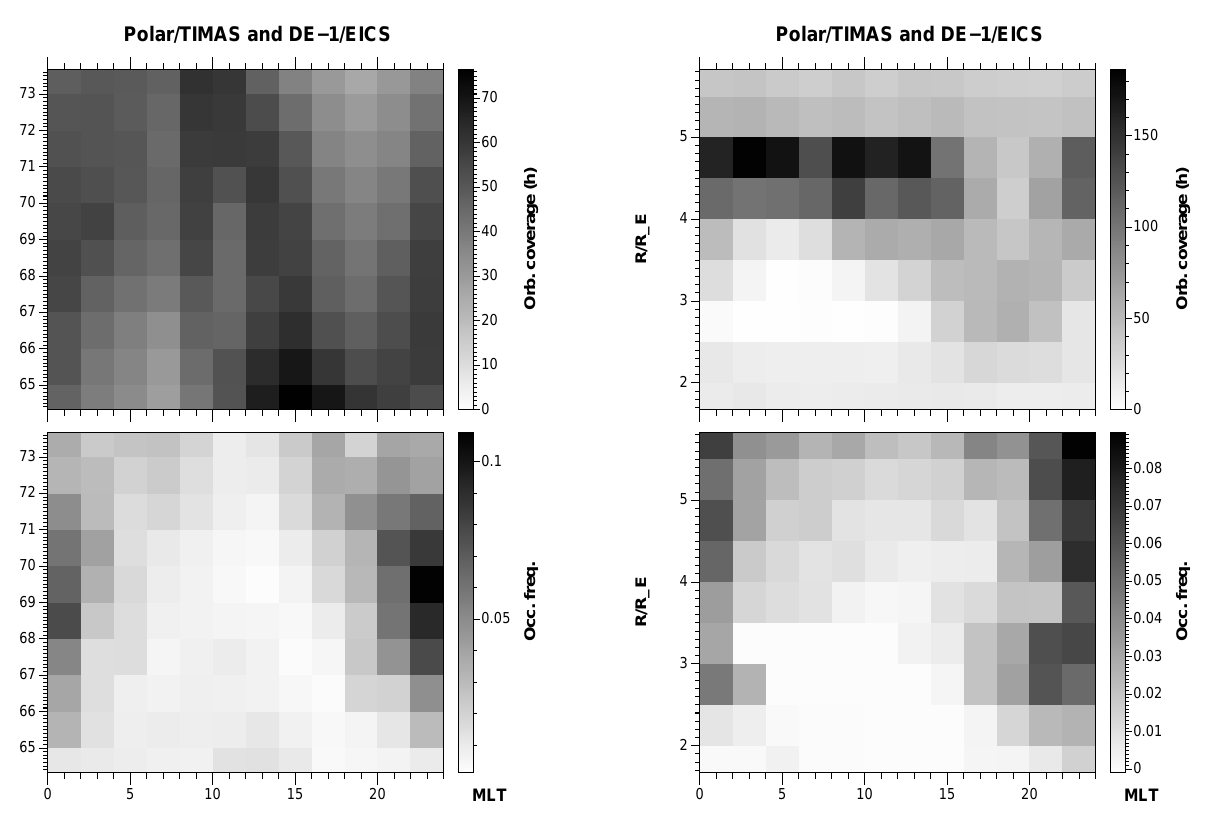
Fig. 8. Top: Orbital coverage in hours in each bin. Bottom: Occur- rence frequency of all 0.5–10keV ion beams as a function of MLT and ILAT for all radial distances smaller than 6 R E . All K p values, all radial bins and data from both TIMAS and EICS are put together. The dayside MLT range 10–14 may contain data errors and should not be looked at.